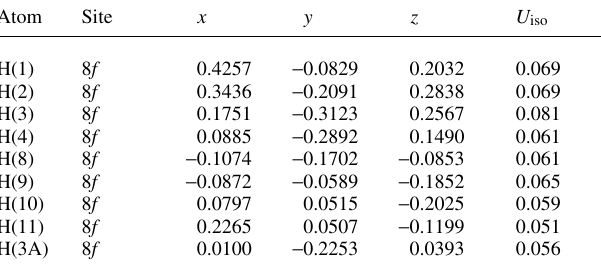
Table 2. Atomic coordinates and displacement parameters (in Å 2 ) .